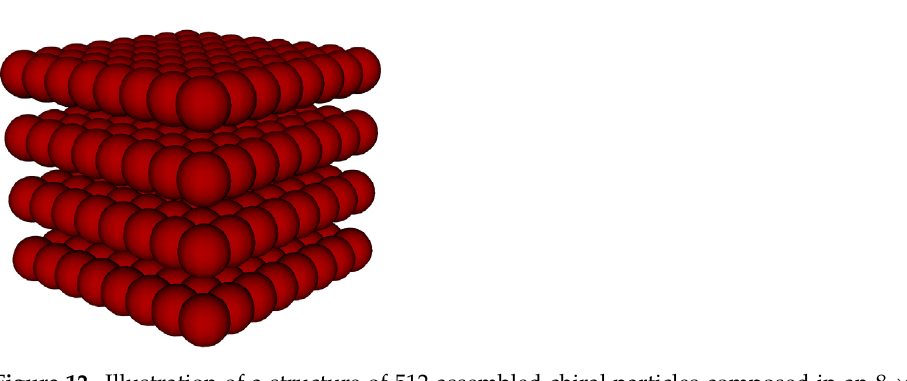
Figure 11. Angular distributions of normalized RCS with varying chiral spheres loss versus scattering angle induced by RCP polarized first-order Bessel beam. ( a ) E-plane; ( b ) H-plane.